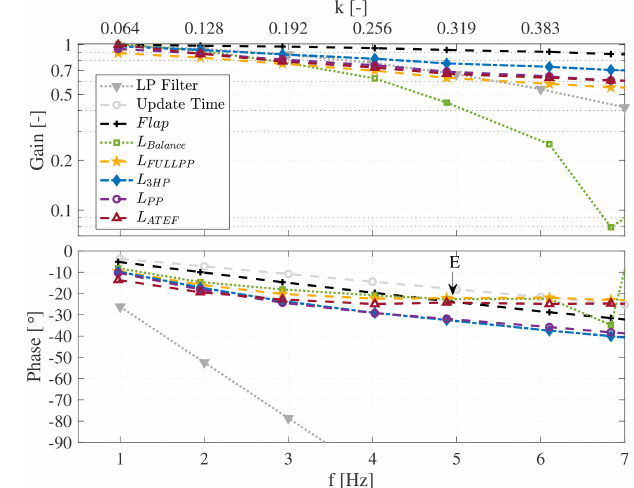
Figure 14. Zoom on the frequency range up to 7Hz of the Bode